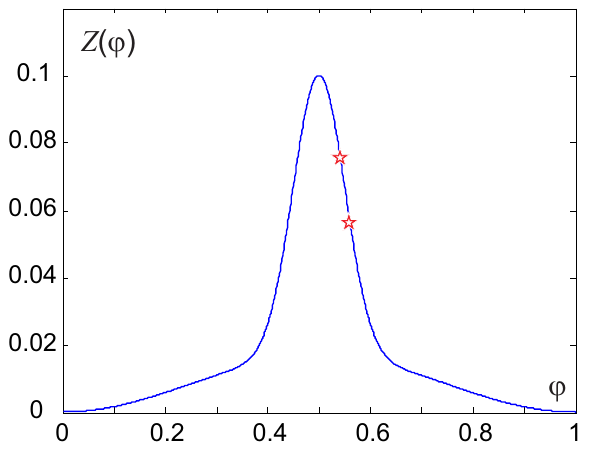
Fig. 2 The PRC for κ = 0 . 1, ε = 0 . 1, q = 40. The stars depict points with Z (cid:48) ( ϕ ) = − 1.